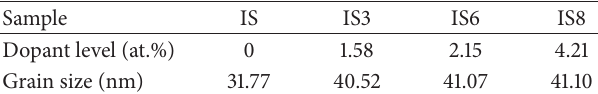
Figure 1: XRD patterns of the In 2 S 3 : Ag films with different dopant S films with 2 3 levels.